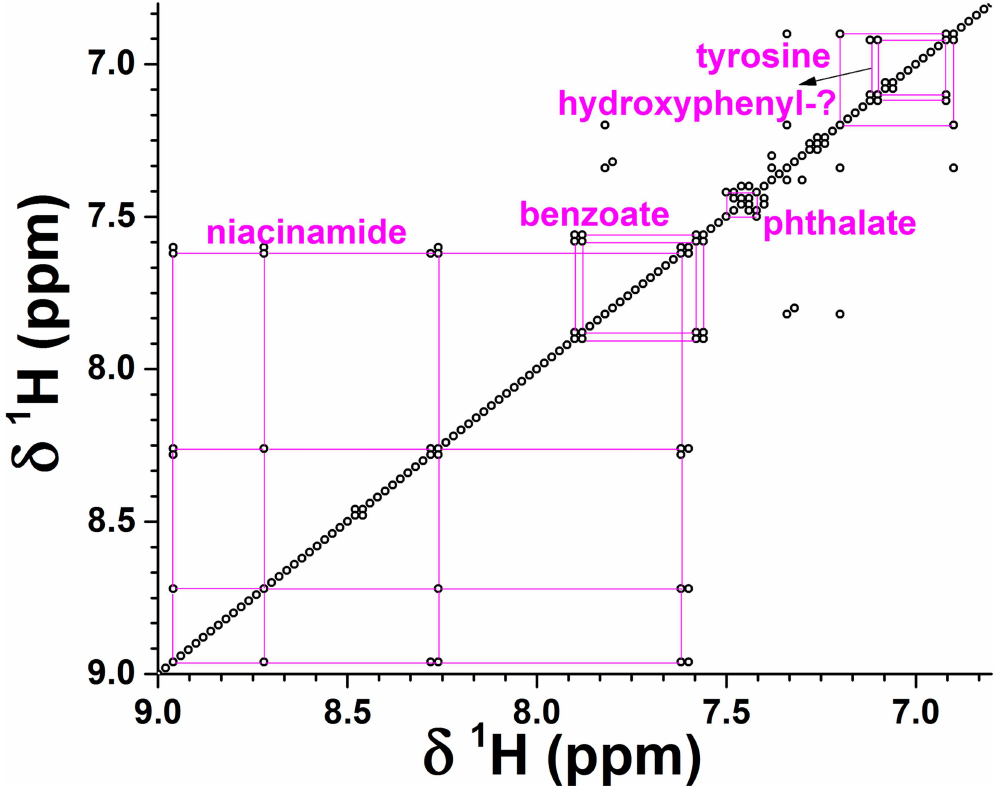
Fig 4. Covalent connectivity of metabolites in feline EBC is suggested by co-variation (STOCSY) among the 106 preprocessed NMR spectra. The aromatic region is plotted. Off-diagonal spots represent correlations (r (cid:21) 0.7) of two chemical groups across the spectra, suggesting that they belongto the same metabolite or pathway.